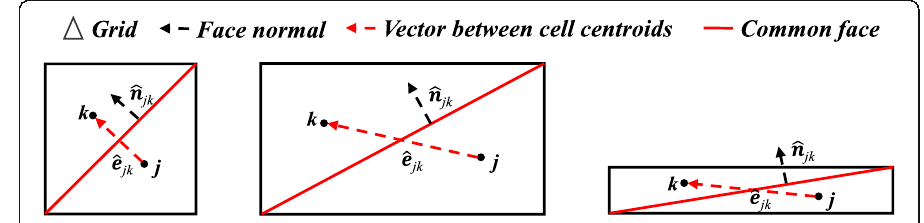
Fig. 6 Grid skewness measure on grids with different aspect